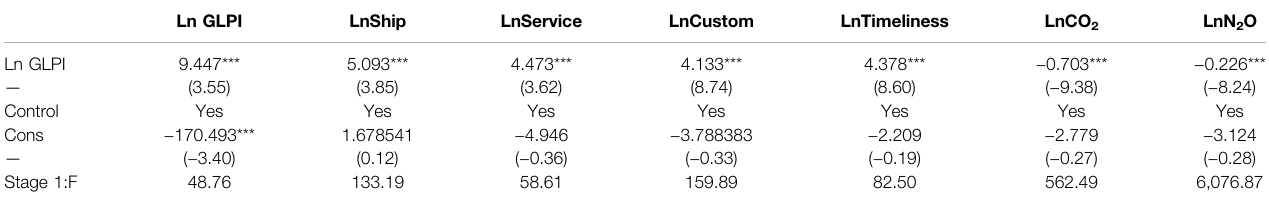
TABLE 8 | Robustness test results of alternative explanatory